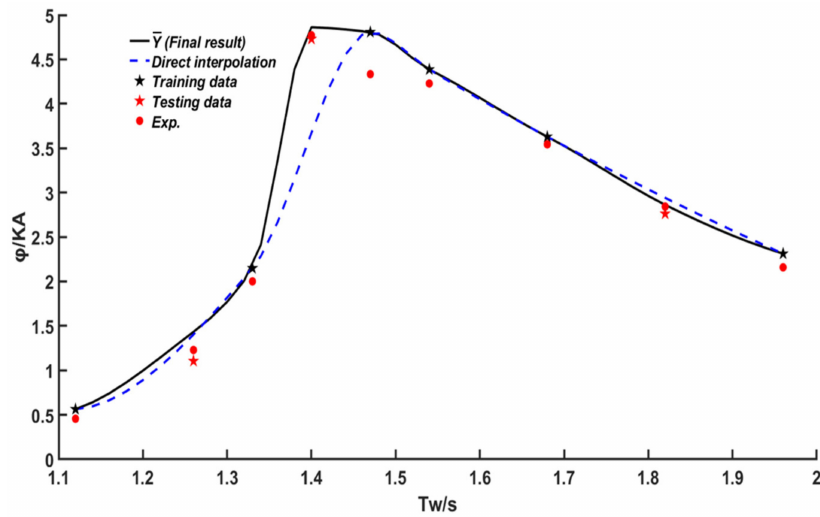
Figure 11. The performance of the proposed model for case no. 4 in Table 4.